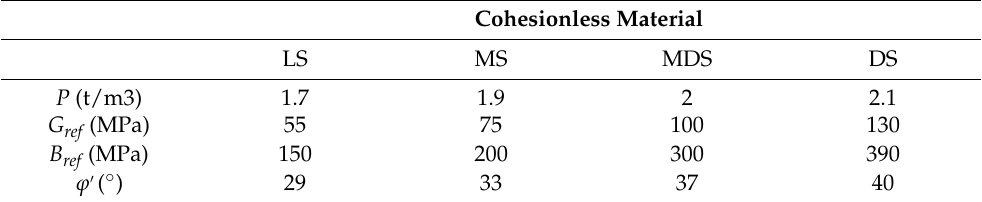
Table 2. Density, ρ , elastic properties (shear and bulk moduli, G ref and B ref ) at a reference